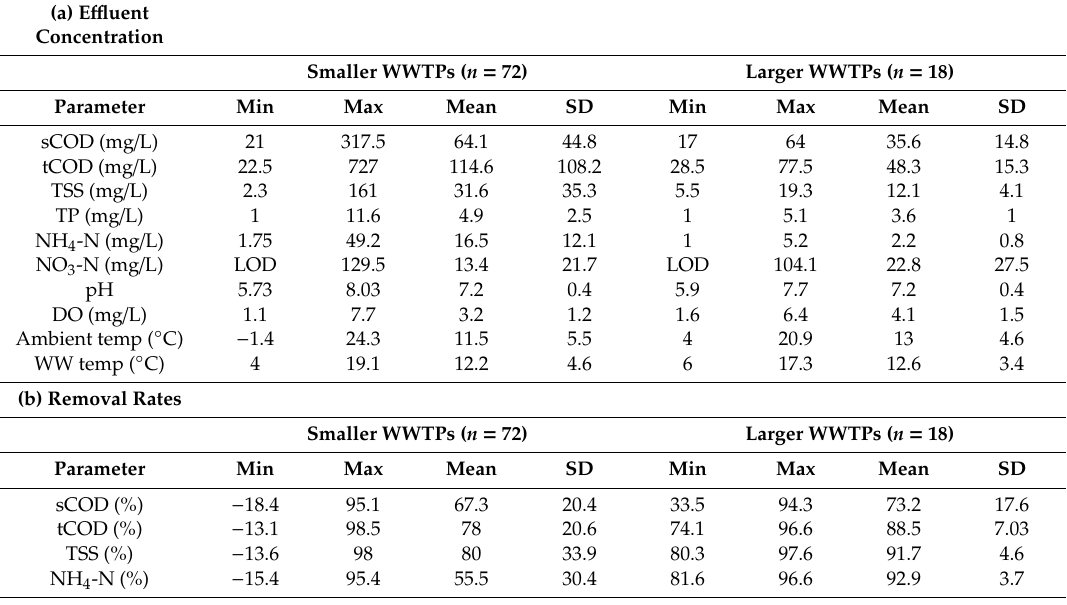
Table 1. Statistical observations of final e ffl uent and removal rate parameters for smaller and larger reference WWTPs. LOD = limit of detection; WW =